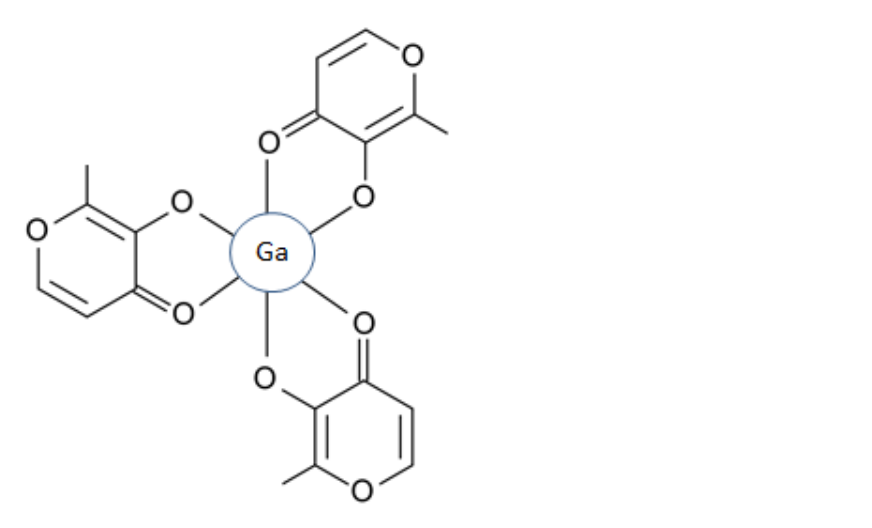
Figure 2. The chemical structure of maltol gallate. Three molecules of maltol are required to form an octahedral complex with one atom of gallium (Ga (III)) at physiological pH. Similar complexes of maltol, and also of deferiprone (L1), are formed with iron and aluminum.